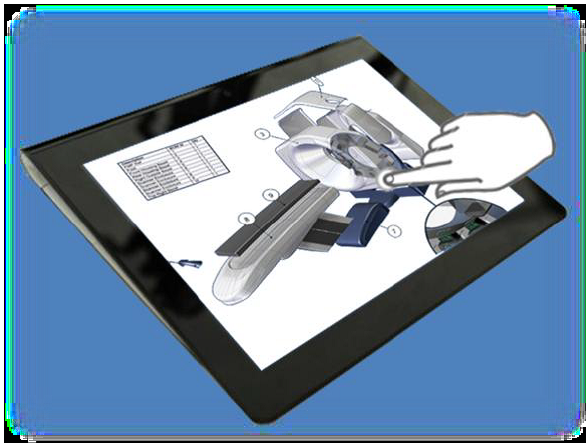
Figure 4: 3D work instruction visualized on tablet [10].